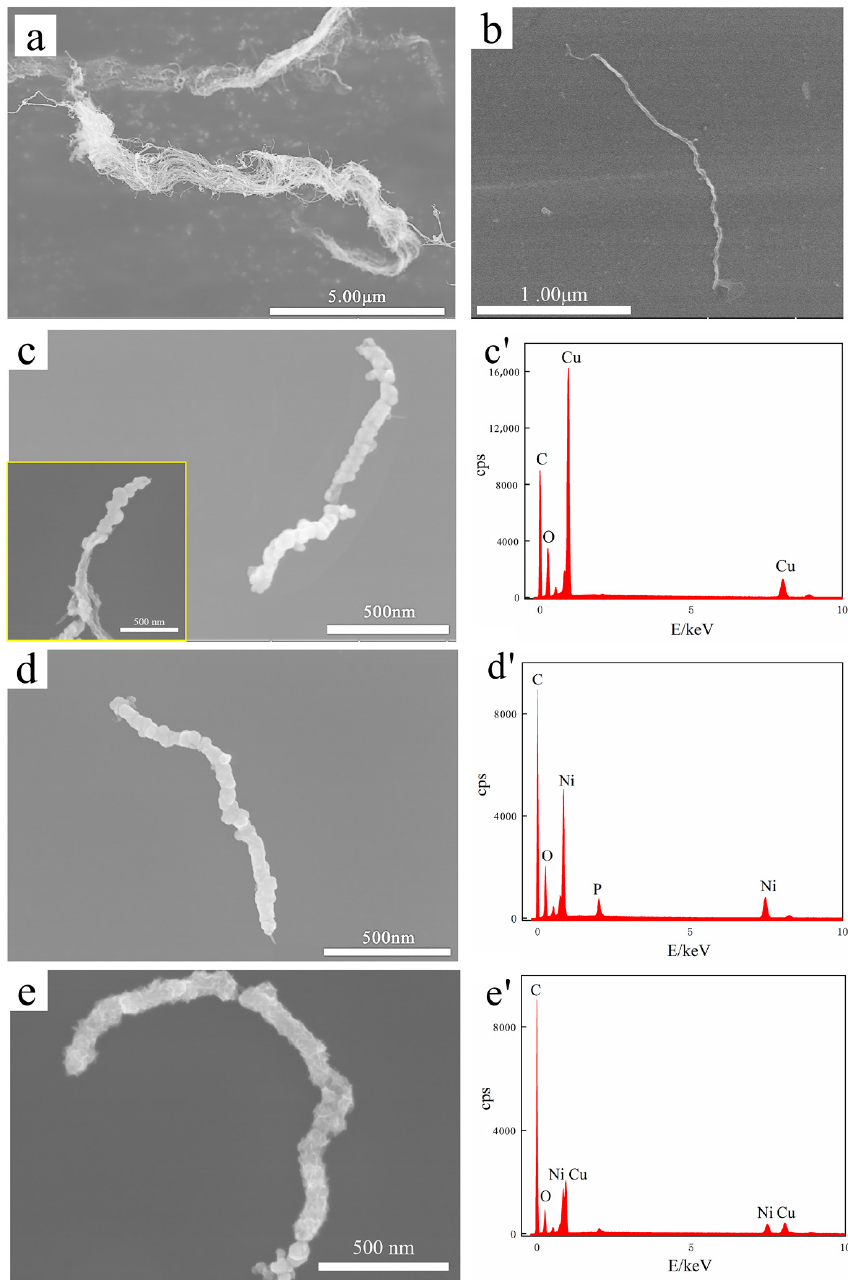
Figure 2. SEM images and EDS analysis of ( a ) pristine MWCNTs, ( b ) MWCNTs after ultrasonic treatment, ( c ) Cu@CNT (The illustration is Cu@CNT at different positions.), ( d ) Ni@CNT, ( e ) Ni&Cu@CNT. ( c’ – e’ ) are EDS analyses of the corresponding sample surface.